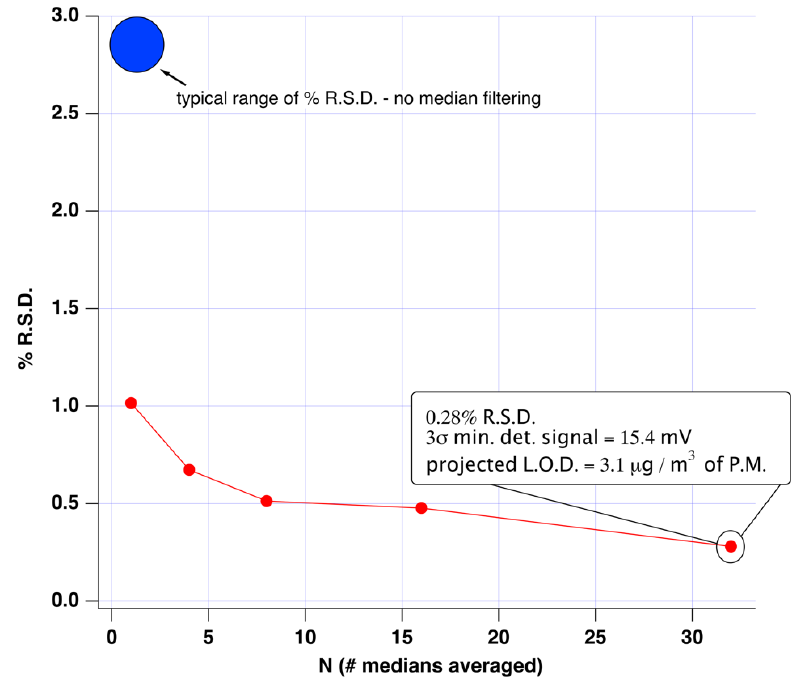
Figure 8. Reduction of noise for the Sharp dust sensor through signal averaging. Signal averaging allowed reduction of noise by 10-fold compared to single pulse analysis. When N = 32 medians were averaged, a noise equivalent limit of detection of approximately 3 µ g m − 3 was